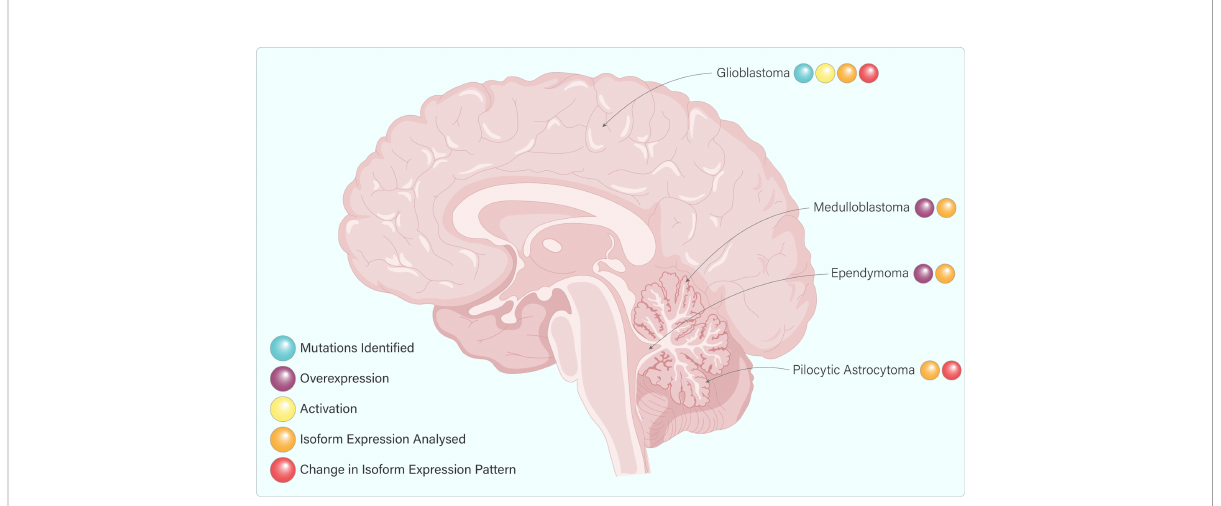
FIGURE 5 ErbB4 expression and activation in various brain cancers. ErbB4 activation and mutations have only been identi fi ed in Glioblastoma. ErbB4 overexpression is observed in medulloblastoma and ependymoma. Isoform expression has been analyzed in all four cancers displayed however only glioblastoma and pilocytic astrocytoma showed a change in the isoform expression